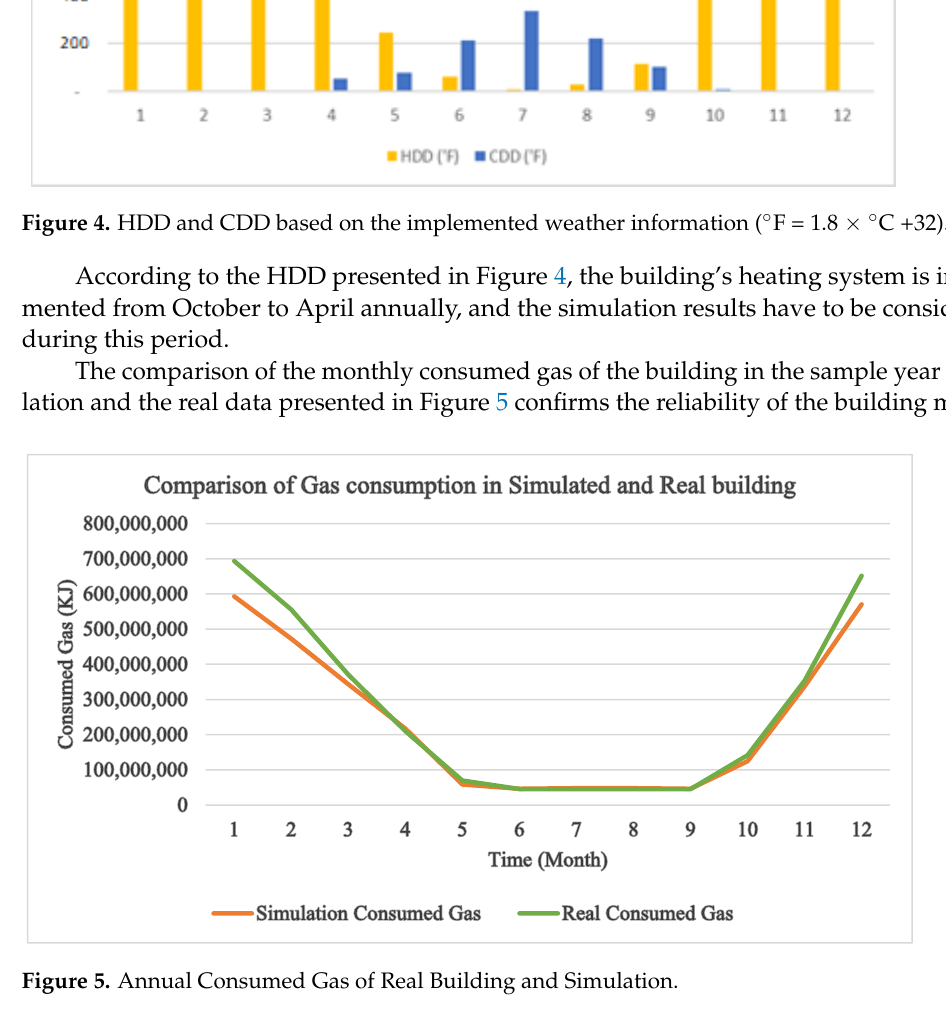
Figure 5. Annual Consumed Gas of Real Building and Simulation.